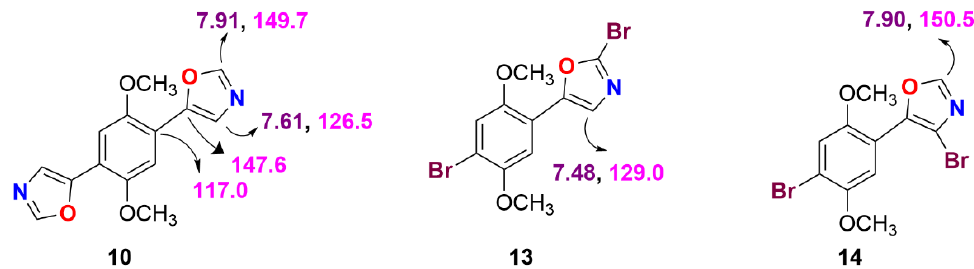
Figure 3. Correlation of 1 H and 13 C NMR value (s) of different oxazole frameworks.